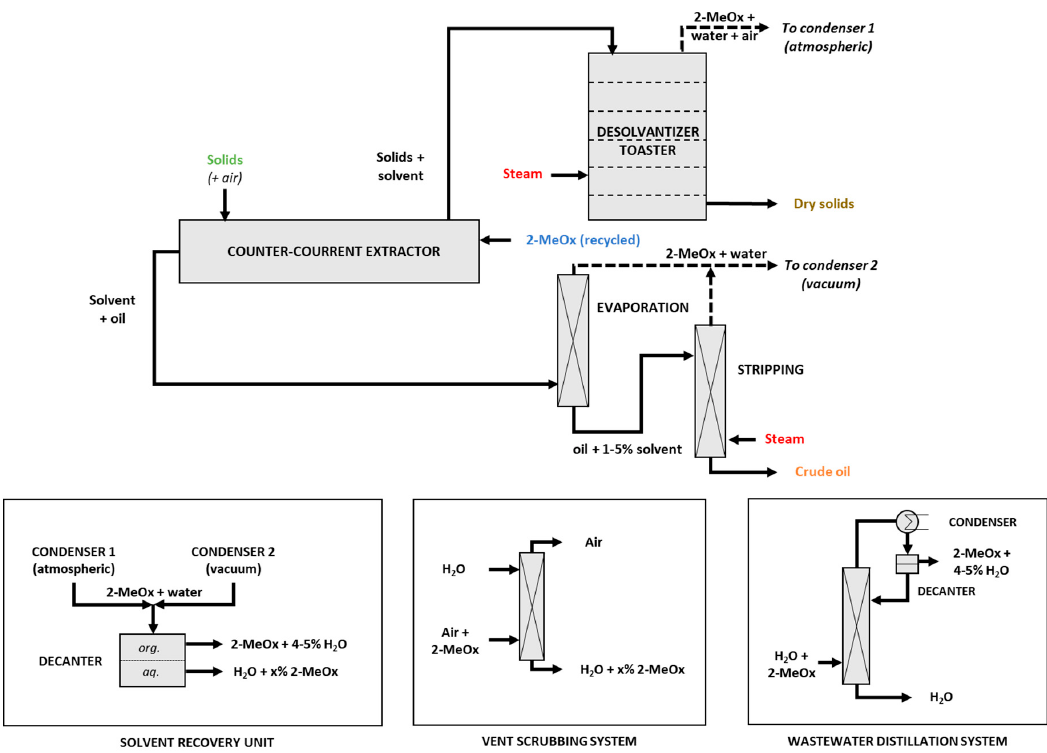
Figure 11. Simplified process diagram of the ENAT International facility (Salamenca, Mexico).